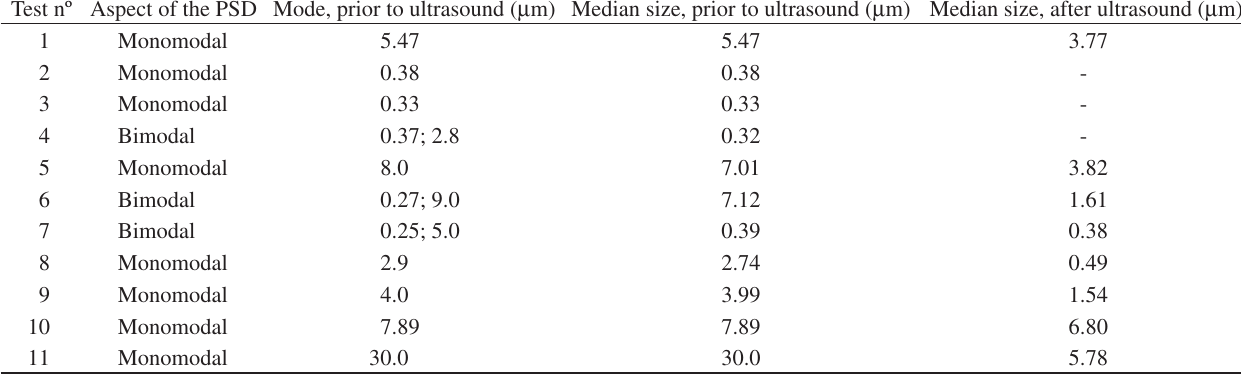
Table 2. Experimental